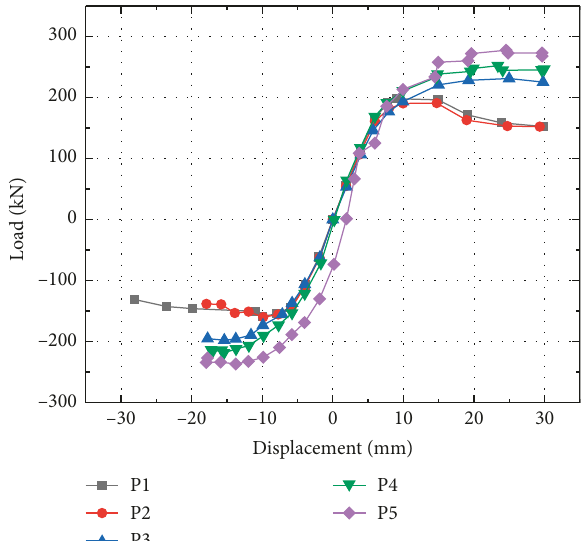
Figure 16: Skeleton curves of numerical